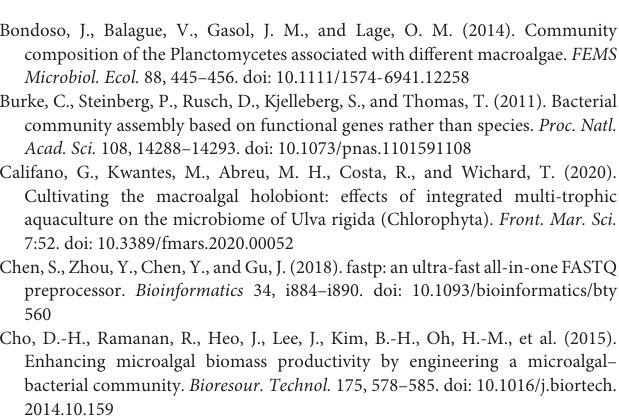
Supplementary Figure 1 | Rarefaction curve analysis of all samples. (A) Rarefaction curves of the bacterial community. (B) Rarefaction curves of the fungal community. Supplementary Figure 2 | Relative abundance of bacteria and fungi per sample in this study. (A) Bacterial community composition at the phylum level. (B) Bacterial community composition at the genus level. (C) Fungal community composition at the phylum level. (D) Fungal community composition at the genus level. Supplementary Figure 3 | Differentially abundant taxa; the length of the histogram represents the impact of the different species. (A) Linear discriminate analysis (LDA = 3) of biomarker bacteria. (B) Linear discriminate analysis (LDA = 2) of biomarker fungi. Supplementary Table 1 | Microbial community sequencing data of the seawater, green macroalgae, red macroalgae, brown macroalgae, and seagrasses. Supplementary Table 2 | A comparison of community alpha diversities between seawater, green macroalgae, red macroalgae, brown macroalgae, and